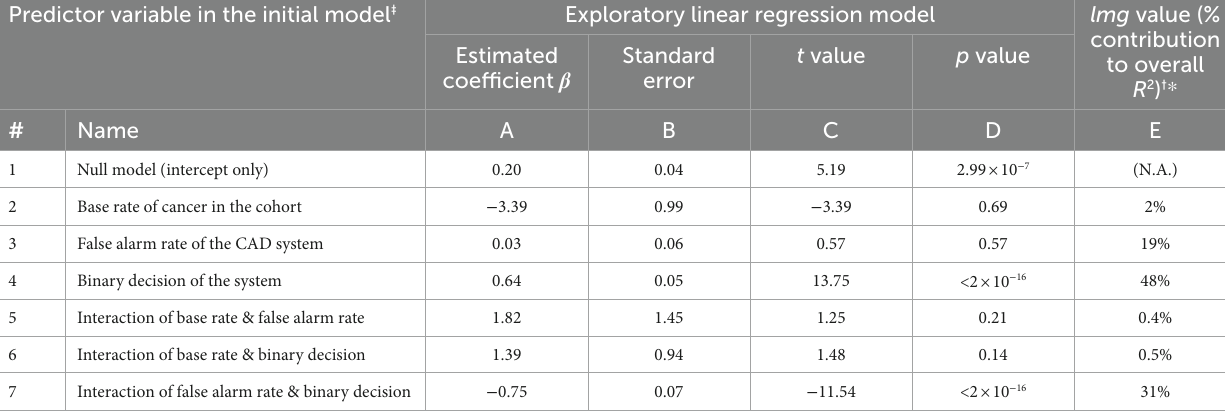
TABLE 1 Summary of regression modeling of the reported probabilities in Experiment 1. Predictor variable in the initial model